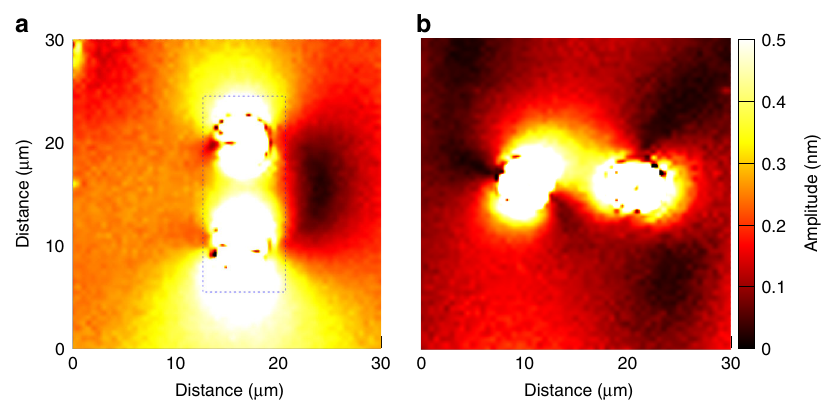
Fig. 5 Surface elastic fi eld distribution. Out-of-plane displacement fi eld maps on the substrate surface for 6 µ m-spaced pillars for a a transverse excitation at 68.53 MHz (iv) and b a longitudinal excitation at 66.26 MHz. The scan area is 30 µ m × 30 µ m, with a step size of 500 nm. The colour scale is saturated to highlight the fi eld displacement at the substrate surface. The dashed rectangle indicates the area corresponding to the data reported in Fig.